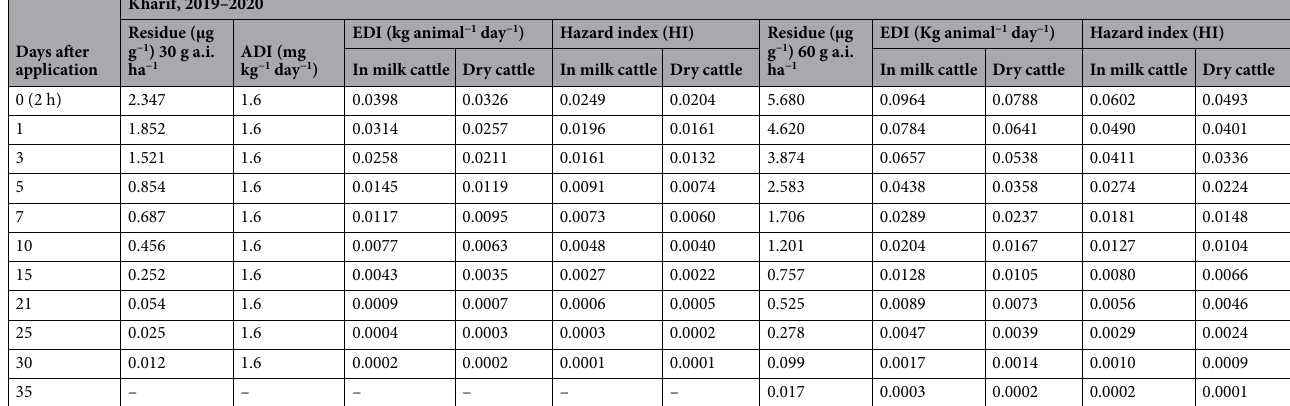
Table 6. Dietary risk assessment of chlorantraniliprole 18.5% WG in cattle’s during kharif, 2019–2020. ADI acceptable daily intake, EDI estimated daily